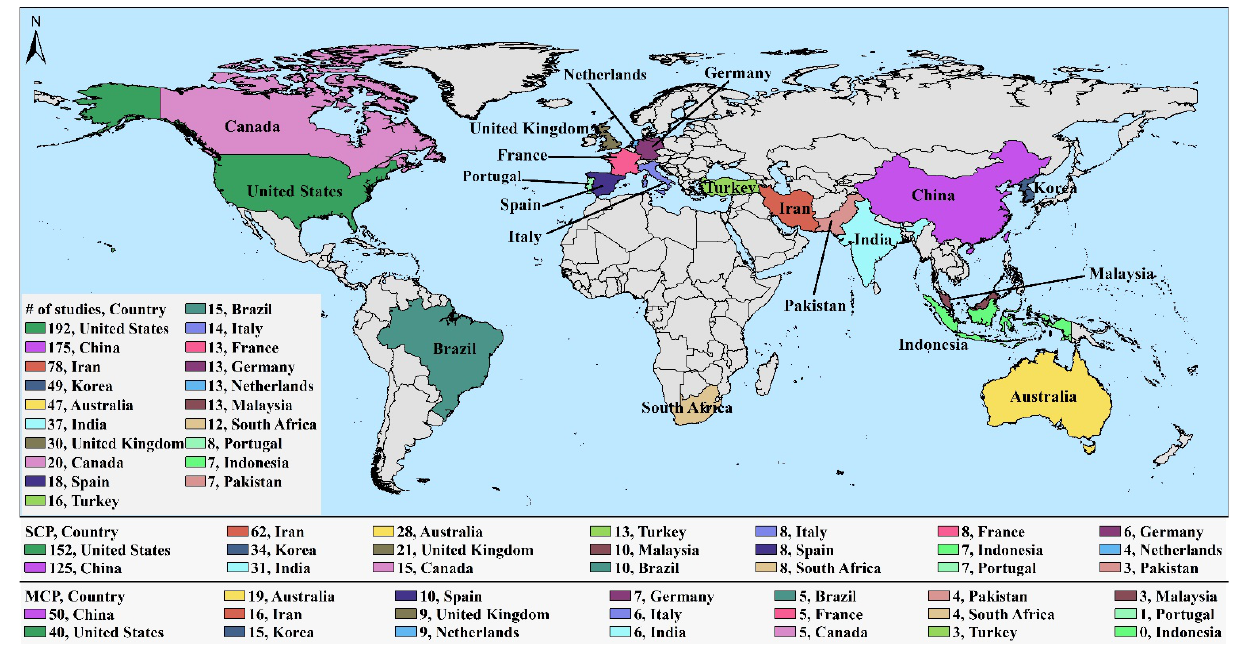
Figure 11. Geographical distribution of top 20 countries based on the number of publications, SCP, and MCP on DF.